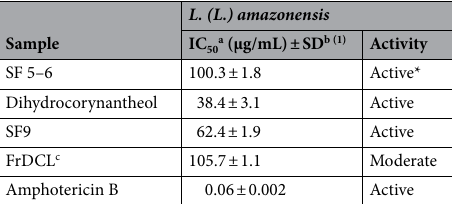
Table 2. Antipromastigote activities of Aspidosperma nitidum . a IC 50 : 50% inhibitory concentration; b SD: Standard deviation; c FrDCL: dichloromethane fraction; (1) 95% confidence interval.